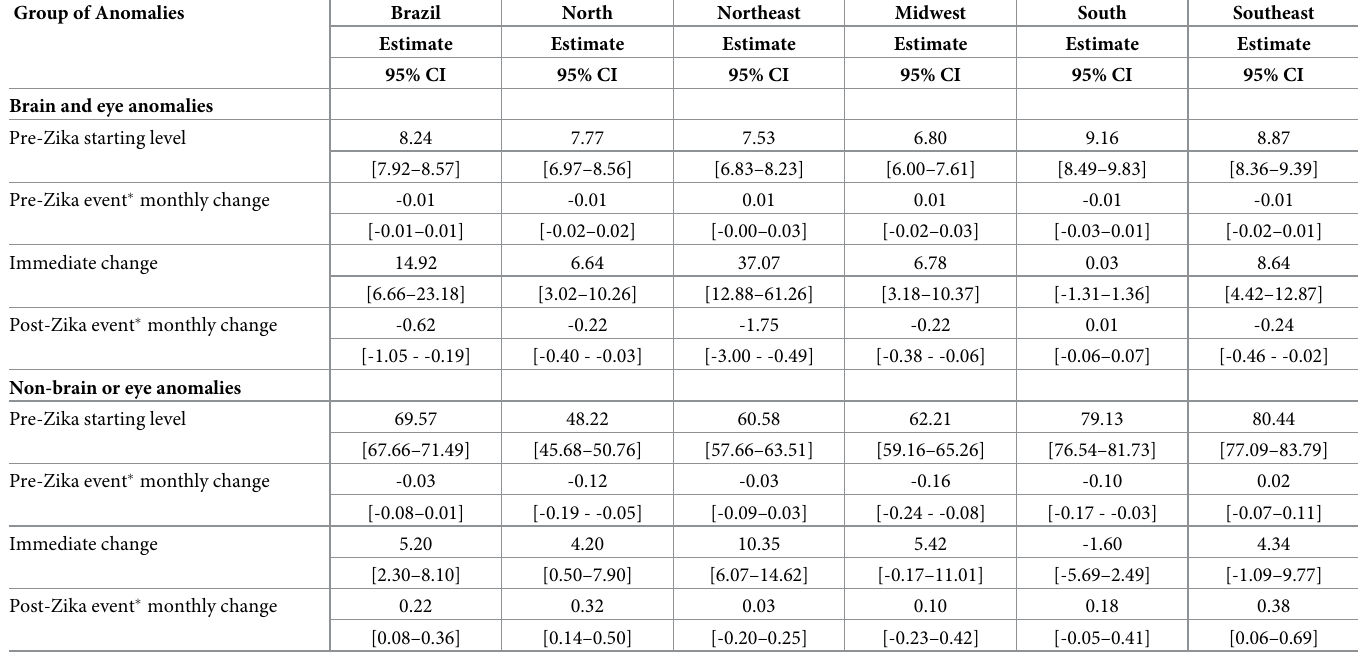
Table 2. Changes in the registration rates of brain and eye anomalies and non-brain or eye anomalies/10,000 live births following the Zika event in Brazil and regions, from 2010–2017. Group of